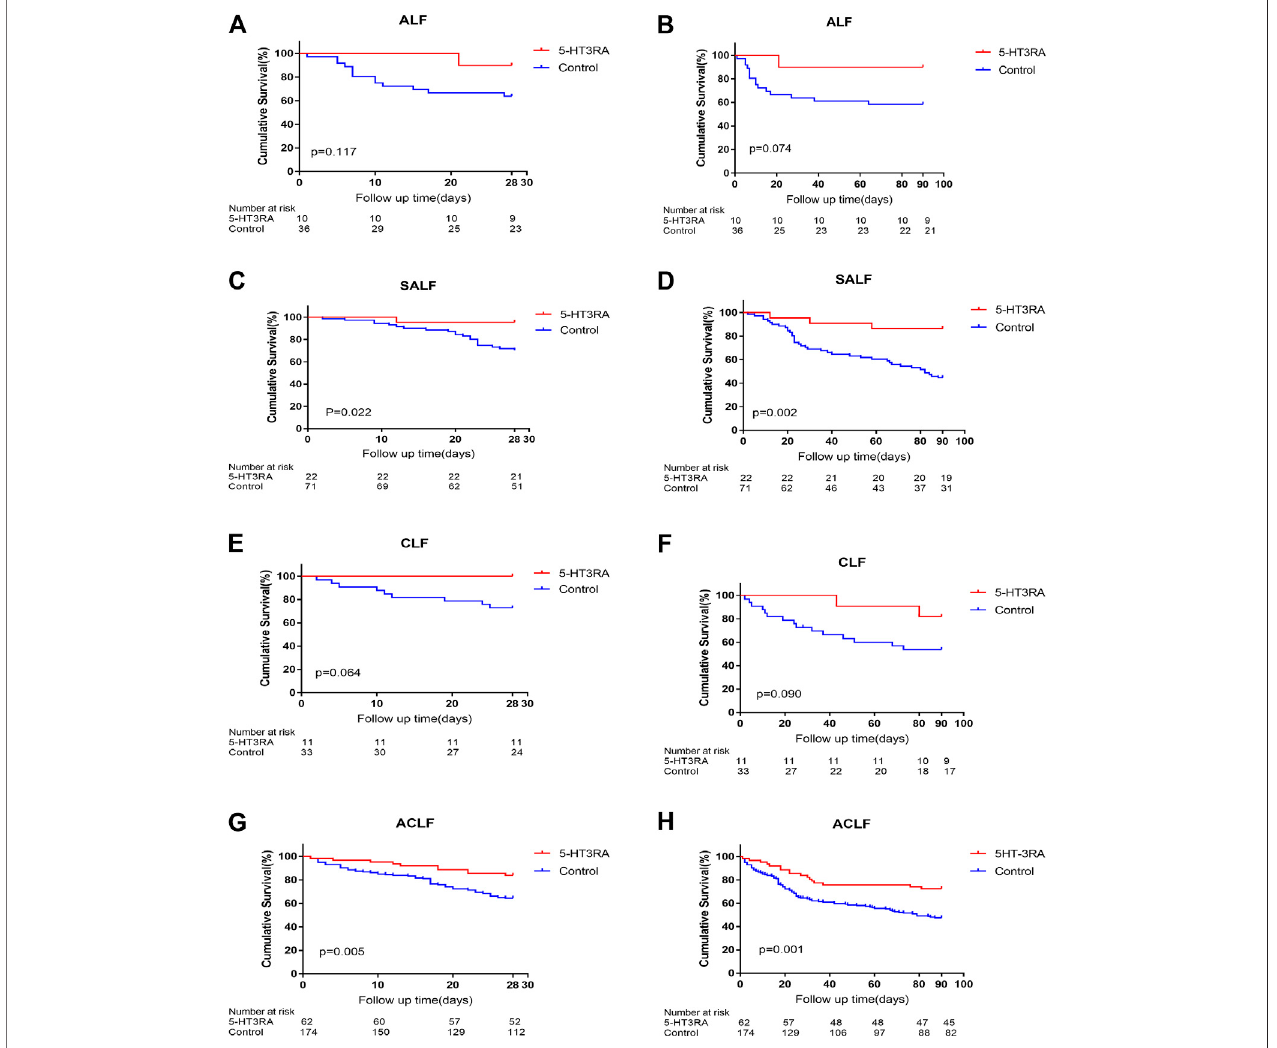
FIGURE 2 | The 28 and 90 days Kaplan-Meier survival curves in different types of liver failure patients with or without the use of 5-HT3 receptor antagonists (5- HT3RA). (A) The 28 days survivals inacute liverfailure(ALF). (B) The90 dayssurvivalsinALF. (C) The28 days survivalsin sub-acuteliverfailure (SALF). (D) The90 days survivalsinSALF. (E) The28 dayssurvivalsinchronicliverfailure(CLF). (F) The90 dayssurvivalsinCLF. (G) The28 dayssurvivalsinacuteonchronicliverfailure(ACLF). (H) The 90 days survivals in ACLF.